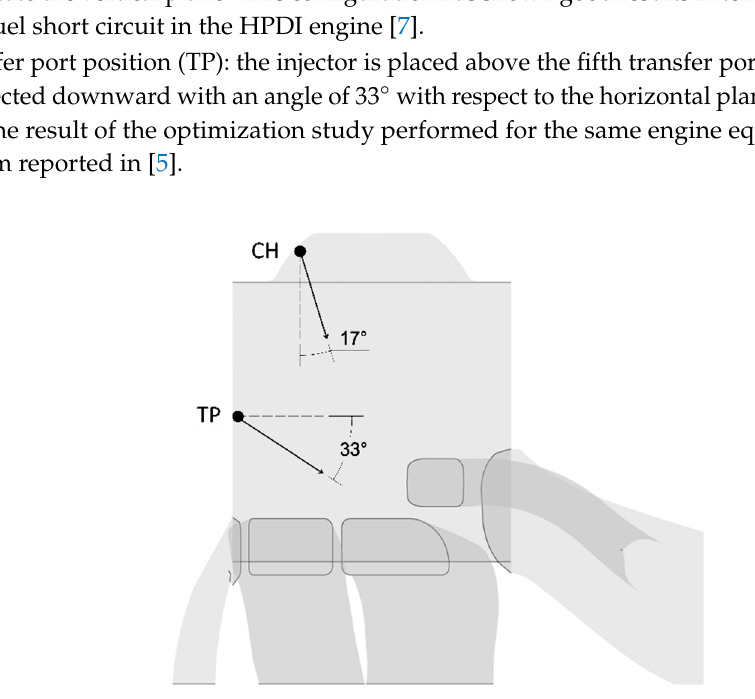
Figure 2. The two injection strategies used in this work: cylinder head position (CH) and transfer port position (TP).